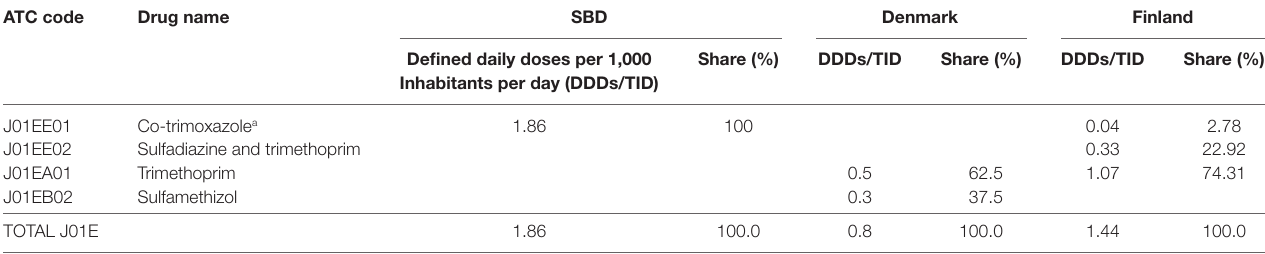
TaBle 7 | Utilization of antibiotics within sulfonamides and trimethoprim subgroup (J01A) in South Backa District (SBD), Denmark, and Finland in 2008. aTc code